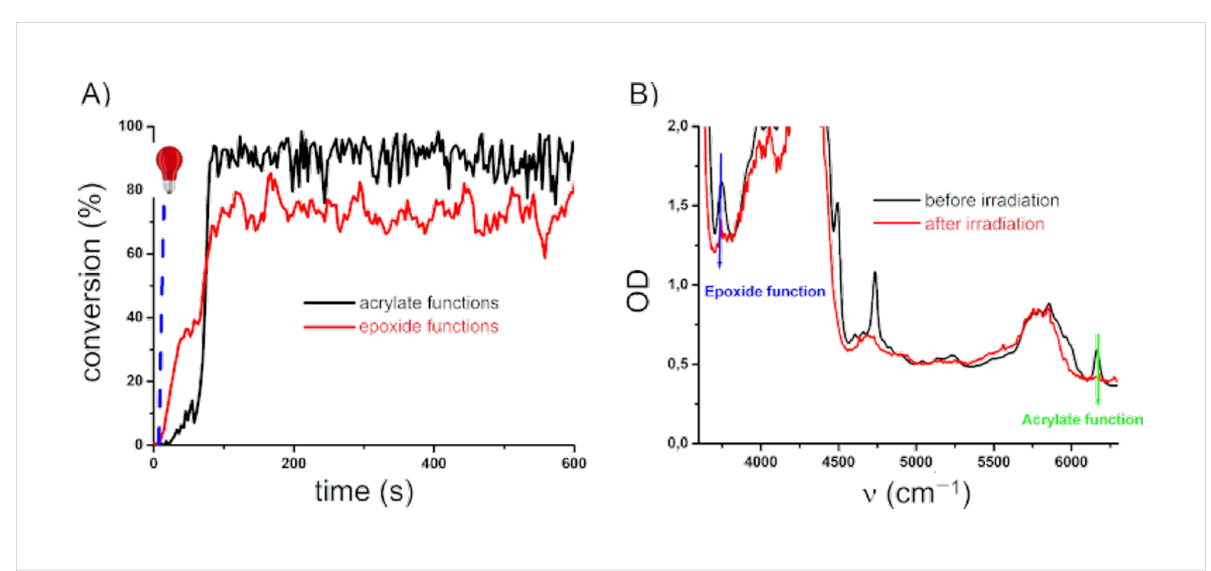
Figure 4: A) Photopolymerization profiles of PETIA/epoxy blend 1:1, w/w under air (acrylate and epoxy functions conversion vs irradiation time) in the presence of Cb /iod 0.3:2, w/w upon exposure to a laser diode at 785 nm (0.9 W/cm 2 ), thickness = 1.4 mm. The irradiation starts at t = 10s. B) FTIR spectra before and after